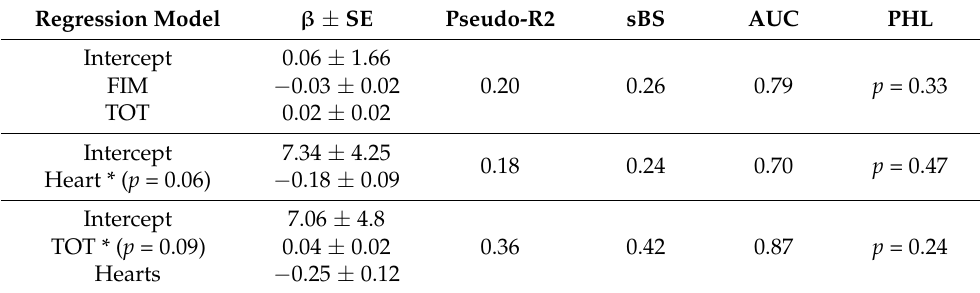
Table 6. Relationship between the FMA-UE Responders and clinical and rehabilitation features. Regression Model β ± SE